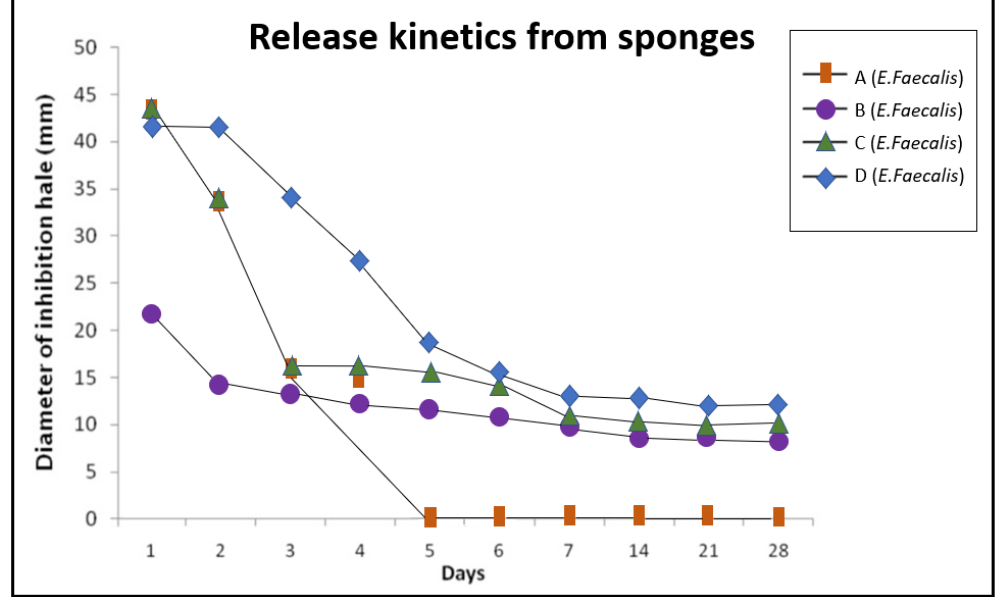
Figure 3. Release kinetics from sponges. Inhibition halos obtained on days against E. faecalis ; square: sponge A; circle: sponge B; triangle: sponge C; rhombus: sponge D.